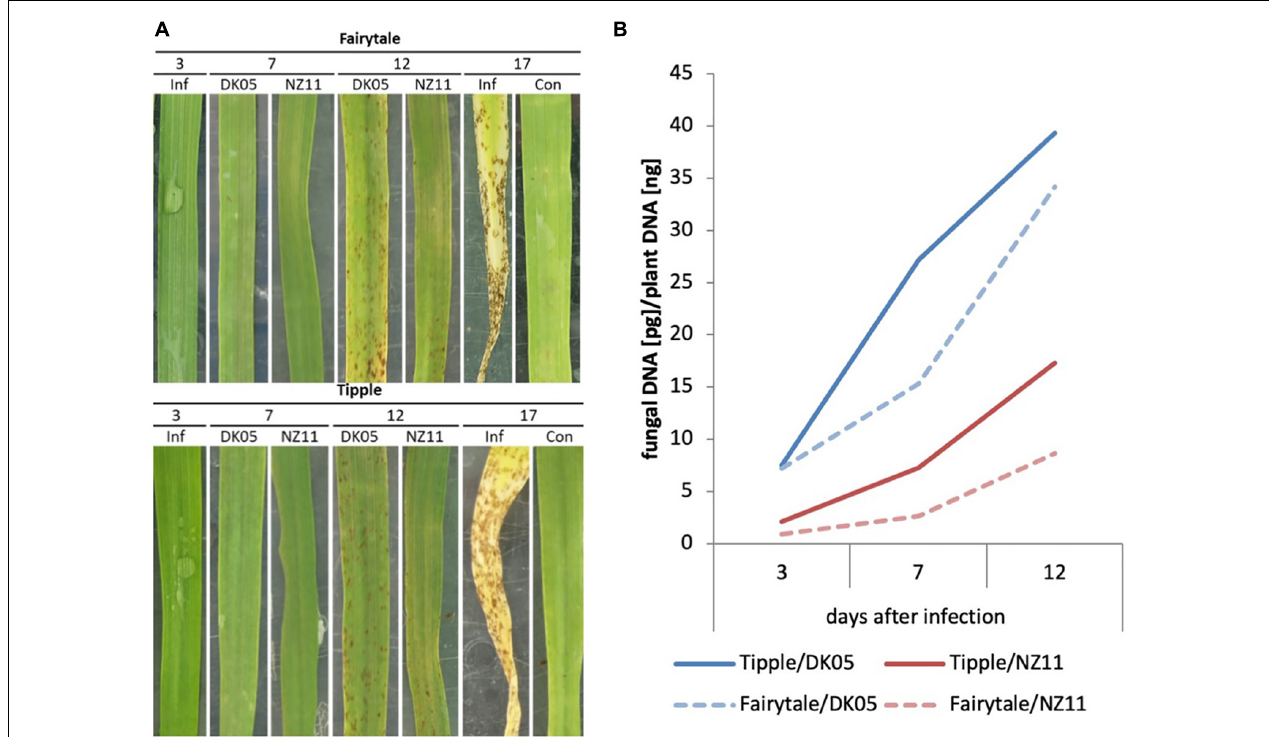
FIGURE 1 | Ramularia leaf spot development and Rcc biomass development of barley leaves ( Hordeum vulgar e L) on cv Tipple and cv Fairytale with two different isolates (NZ11 and DK05). (A) Development of necrotic leaf spots throughout the monitored time course experiment at 3, 7, 12, and 17 days post inoculation (dpi). At 3 dpi an exemplary picture of an infected (Inf) but symptomless leaf was included. This phenotype was seen for both isolates. 17 dpi was included to show the complete collapse of an infected host leaf in comparison to an mock-inoculated leaf (Con), indicating accelerated senescence due to infection. (B) Relative content of Rcc DNA in infected samples at 3, 7, and 12 days post infection (dpi). Two different isolates [Rcc DK05 (aggressive), Rcc NZ11 (mild)] were monitored on two different barley cultivars (cv Tipple and cv Fairytale).